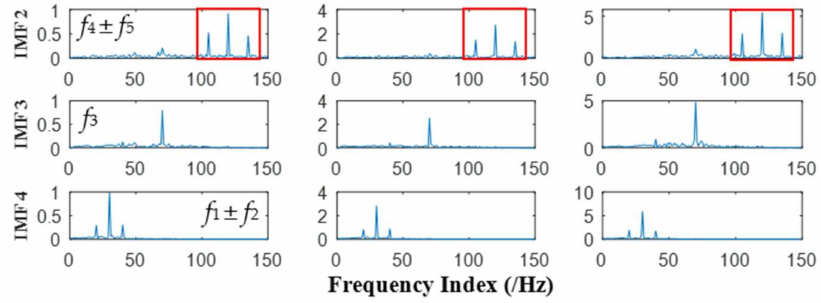
Figure 11. Frequency domain plots of effective IMFs of APIT-MEMD.